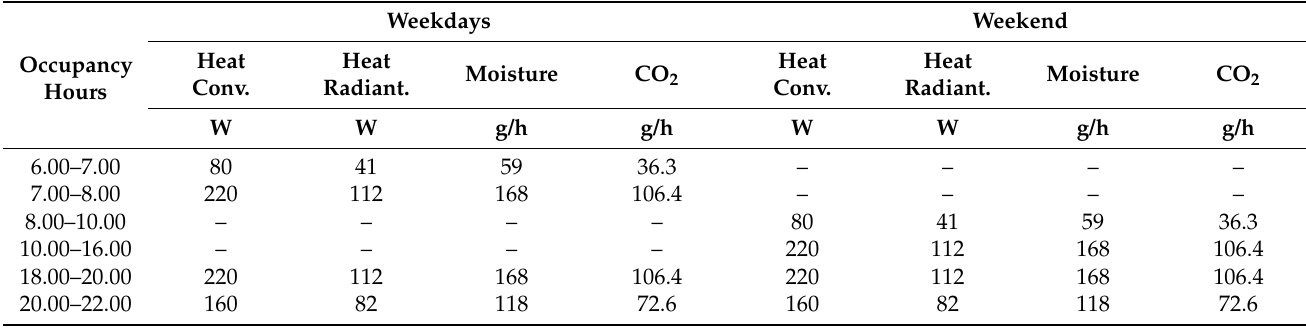
Table 1. Occupancy schedule with internal heat gains.